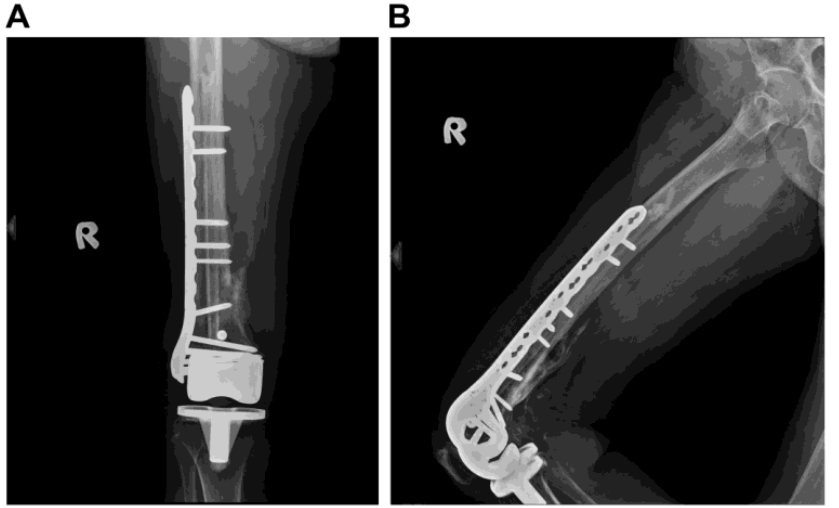
Figure 4. Radiographic images taken 4 months after the surgery. ( A ) Anteroposterior (AP) view of knee. ( B ) Lateral view of knee. The patient achieved a solid bone union.